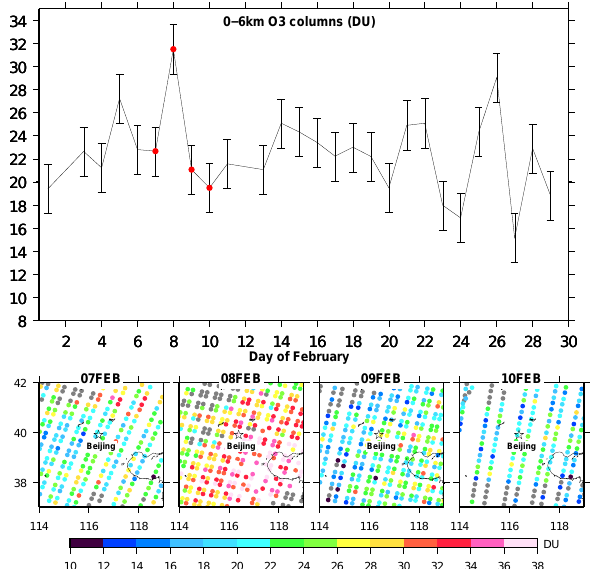
Figure 12. 0-6km ozone columns (morning pass) retrieved from IASI over the Beijing region and averaged over the domain as a function of day (top). The corresponding spatial distribution of the partial columns for 4 selected days from February 7 th to February 10 th , marked with red dots in the upper panel, is plotted in the bottom. Each circle corresponds to one IASI pixel. Grey circles represent cloudy pixels.